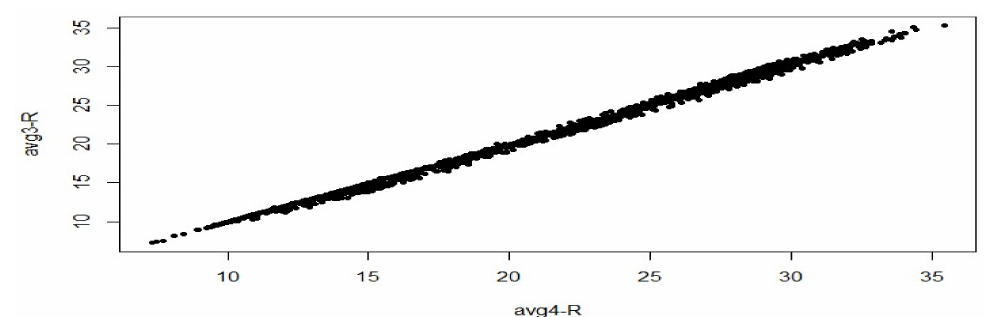
Figure 18. Avg1-R and avg2-R relationship.